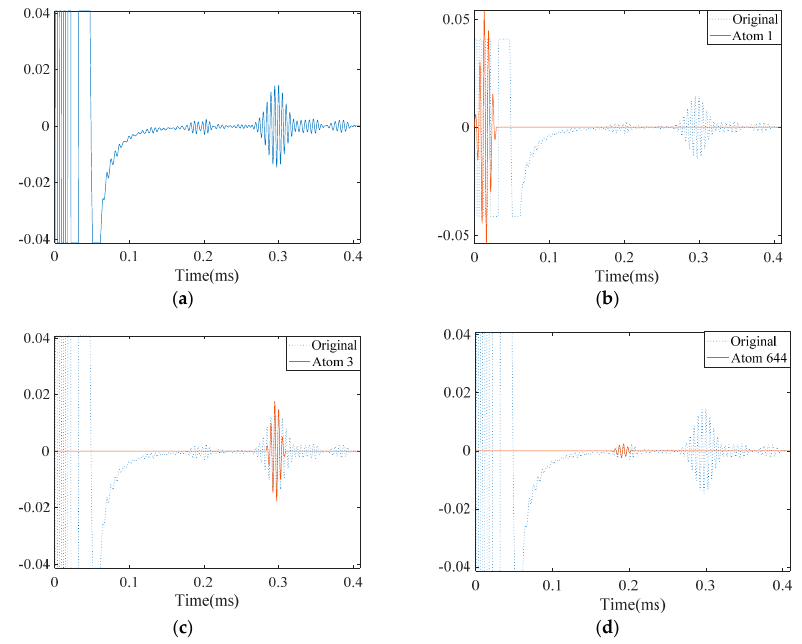
Figure 18. The experimentally measured signal in a pipe with two cracks and its approximation by MP: ( a ) the originally measured signal; ( b ) approximated atom 1—the incident signal; ( c ) approximated atom 2—the reflection from the pipe end; ( d ) approximated atom 3—the reflection from the first crack; and ( e ) approximated atom 644—the reflection from the second crack.